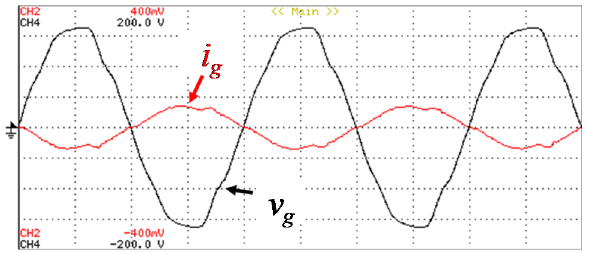
Figure 15. Experimental results during the MF-EVCS operation in V2G mode combined with the